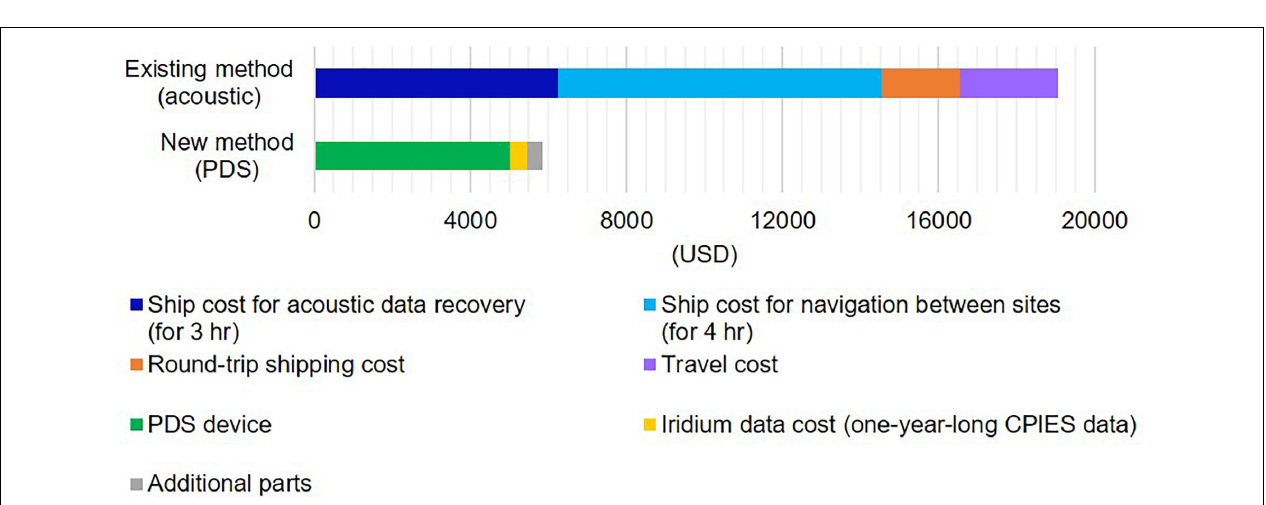
FIGURE 5 | Two PDS trajectories released at AES4 site on September 24, 2018 (1st PDS) and August 1, 2020 (3rd PDS). White line indicates the 1st PDS trajectory with the green, magenta, and cyan dots along the line denoting daily locations in the years 2018–2020, respectively. Black line indicates the 3rd PDS trajectory with the white and red dots along the line denoting locations every day and 6 h, respectively. Note that bad locations ( ∼ 5%) are not shown. Yellow (AES4) and blue (AES 1–3, 5, 6) dots indicate CPIES sites as in Figure 2 . Dots at certain locations with mm/dd or mm/dd/yyyy date designations mark the PDS positions at 00 h GMT on those